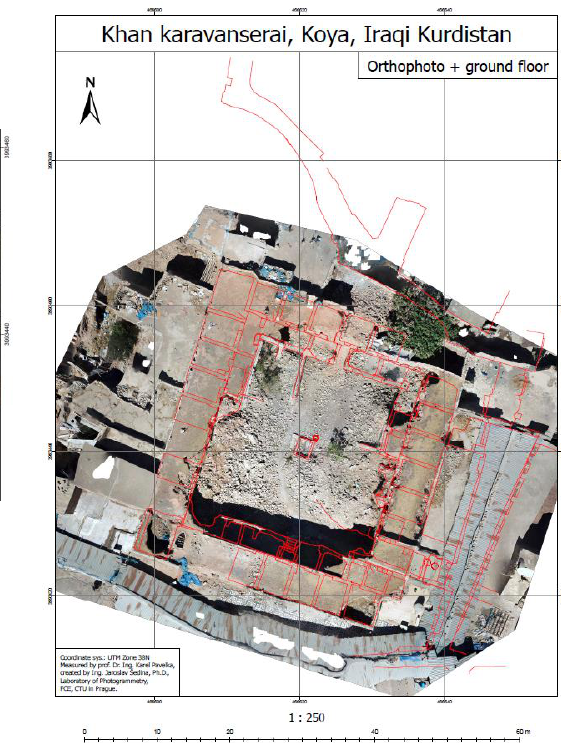
Figure 8 a,b. Orthophoto map of the current state of the almost demolished Khan caravanserai in Koyasenjaq; 5a ortophoto from first flight partial distorted, 5b orthophoto from second flight without dark shadows The vector data created in point 4.1 was used as an additional layer with the orthophoto to indicate the correct position of the chambers which are left beneath the ruins. Vector layer for the ground and the first floor was used and the results can be seen in Figure 9 and Figure 10.